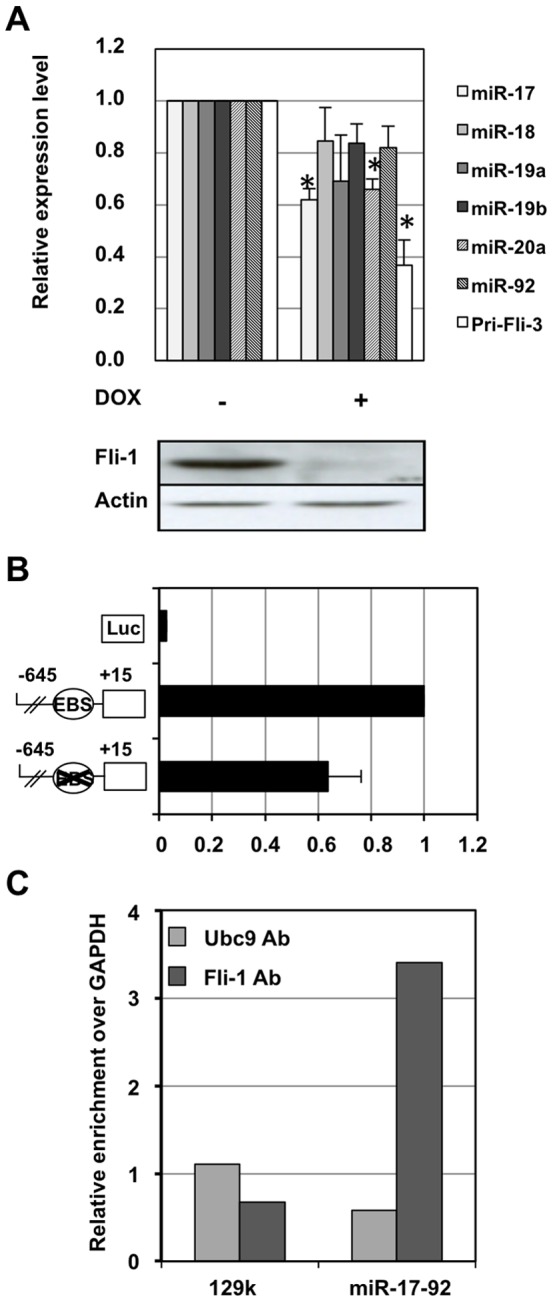
Fli-1 directly activates miR-17-92 promoter and contributes to miR-17 and miR-20a expression in NN10#5 cells.A: NN10#5 cells have been cultured for two days in absence or presence of Dox used to induce Fli-1 knock-down before analysis. Histogram shows the relative decreases of pri-miRNA-17-92 transcript and mature miRNA levels in treated versus untreated cells (means and standard deviations from 3 independent experiments) with significant (p<0.01) decreases indicated by asteriks. A western blot analysis confirming the strong decrease of Fli-1 protein in treated cells is shown under the histogram. B: Reporter gene assay showing promoter activity of the −645/+15 region and its partial dependency on the conserved −78 EBS. NN10#5 cells were co-transfected as indicated for 745#44 cells in Figure 2B. C: ChIP analyses performed in NN10#5 cells using Fli-1 or control UBC9 antibodies followed by q-PCR of miR-17-92 promoter and GAPDH or 129k negative control regions. Results are expressed as relative enrichments normalized to background enrichment determined on the GAPDH region (results from a single experiment).